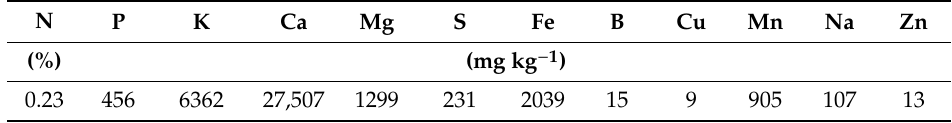
Table 1. Nutrient analysis of the biochar used in the